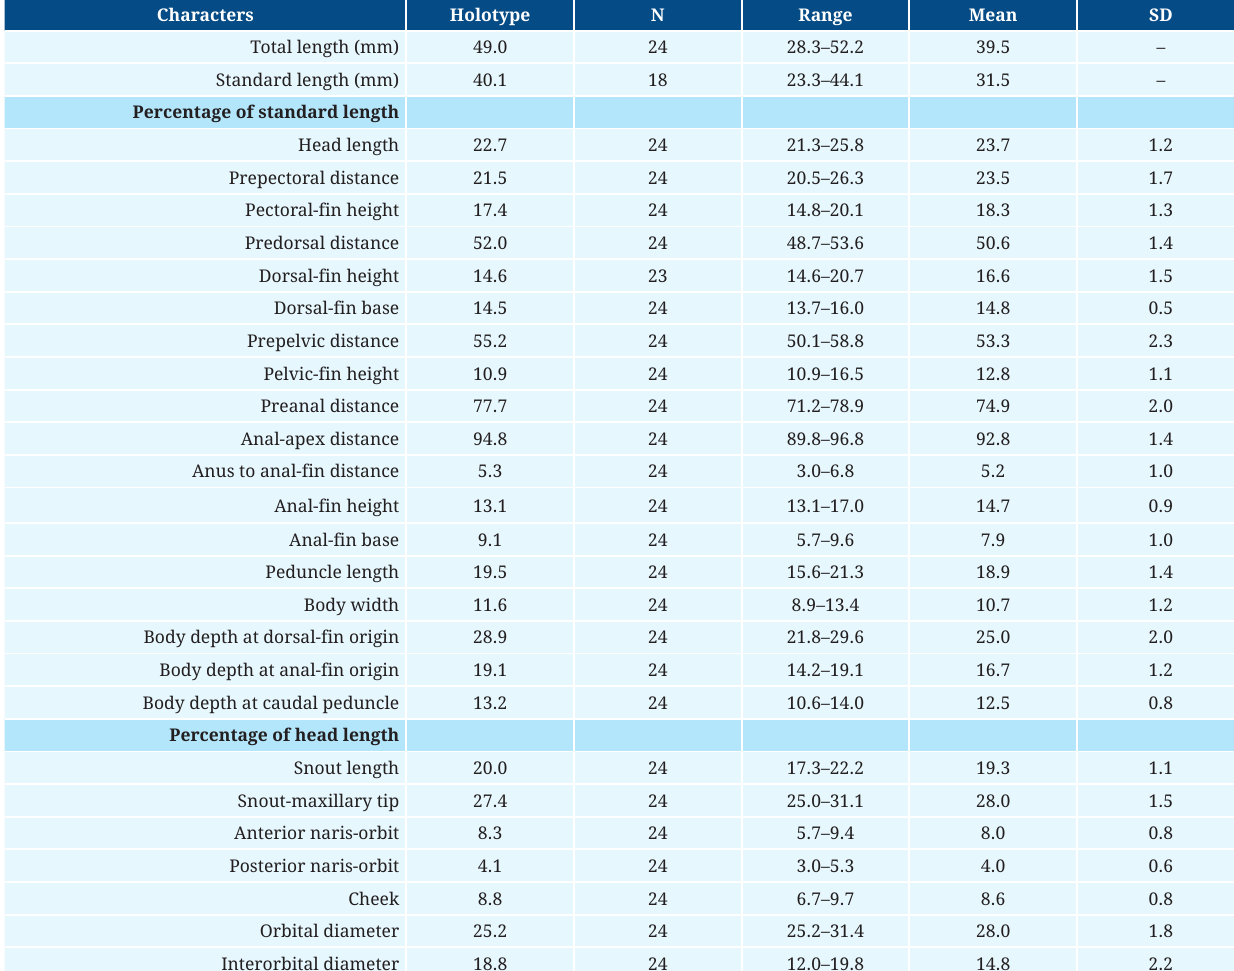
TABLE 1 | Morphometric data for Characidium onca . Range values are for holotype and paratypes. N = total number of specimens examined; SD = Standard